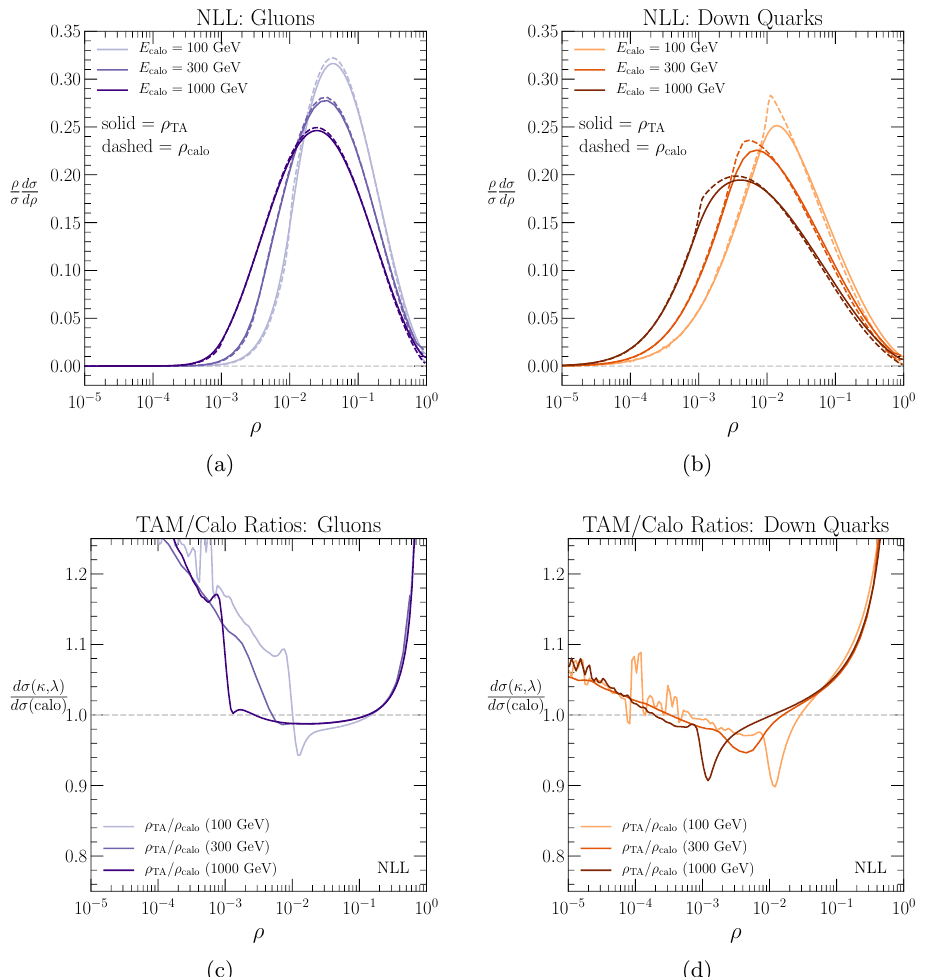
Figure 9 . Top row: resummed distributions at NLL for rescaled jet mass (cid:26) calo (dashed curves) and rescaled track-assisted mass (cid:26) (solid curves) with R = 1 for (a) gluon-initiated jets and (b) TA down-quark-initiated jets. Shown are three di(cid:11)erent values of the jet energy, E calo = 100 GeV, 300 GeV, and 1000 GeV. Bottom row: ratios of (cid:26) TA =(cid:26) calo at the same jet energies to highlight the di(cid:11)erences in the distributions.